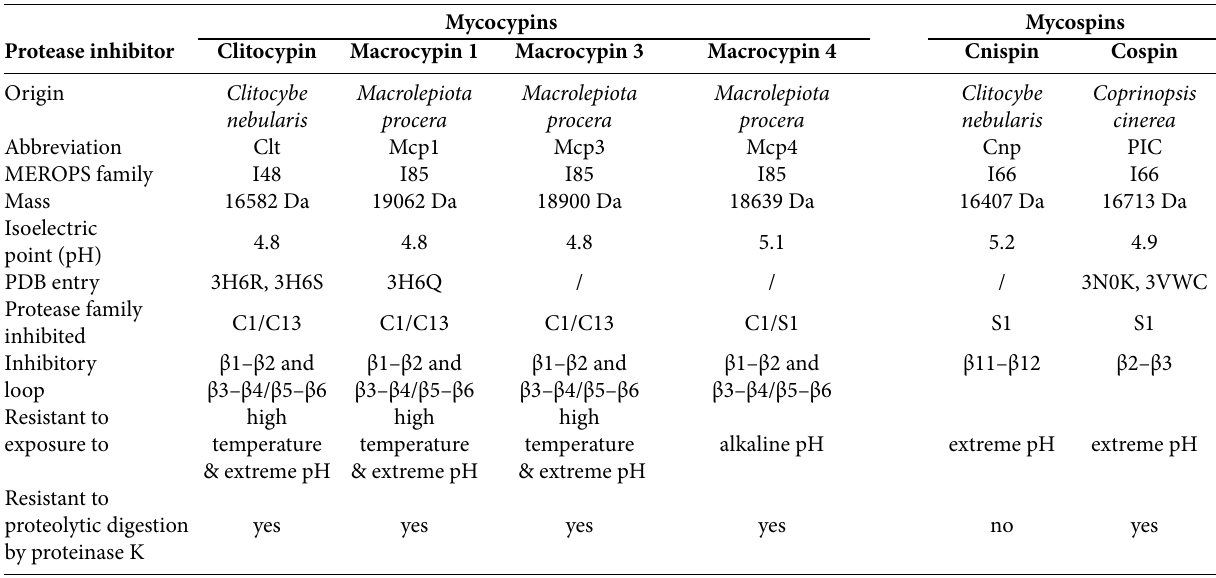
Table 1. Overview of β-trefoil protease inhibitors from higher